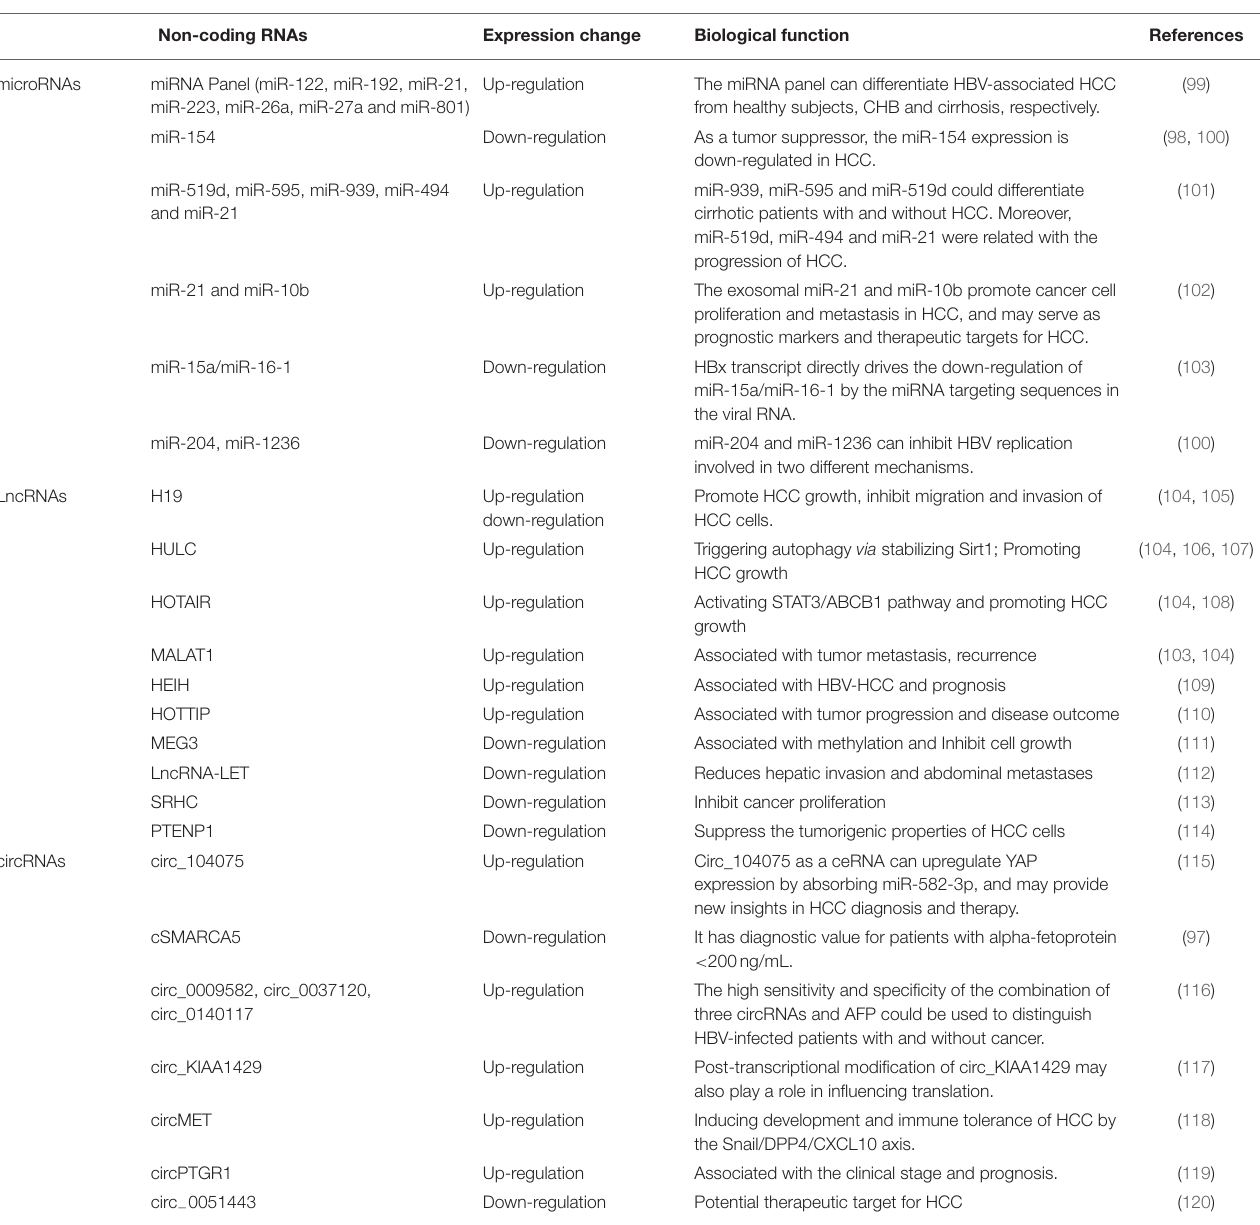
TABLE 3 | Non-coding RNAs in